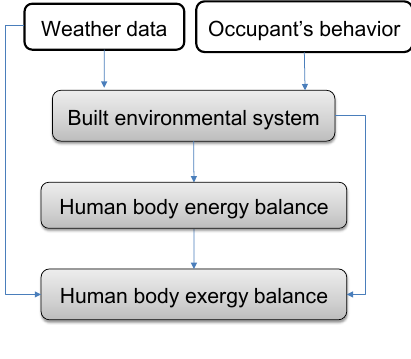
Figure 3. Calculation